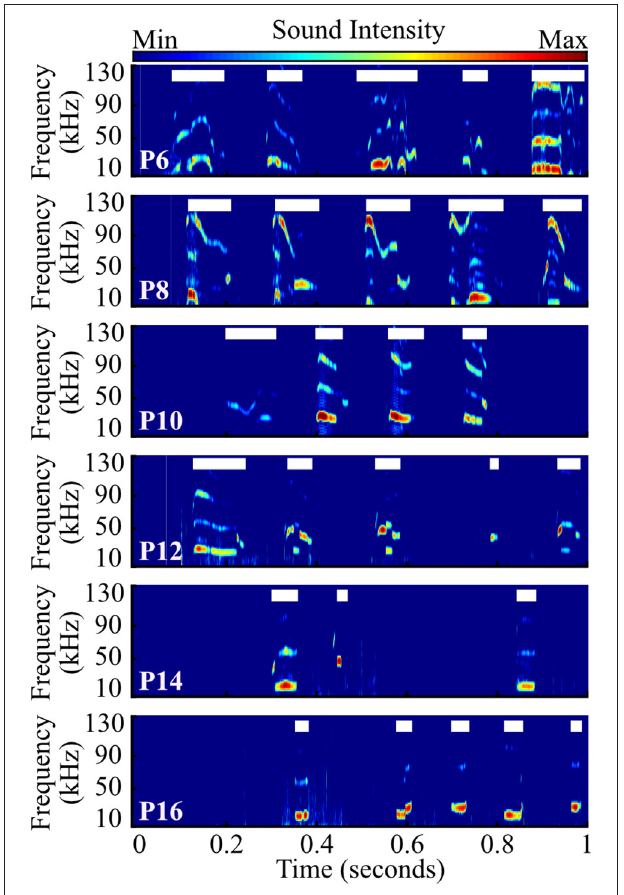
FIGURE 3 | Representative examples of pup vocal activity across development. Example spectrograms contain one second of audio data recorded from prairie vole pups aged P6–P16. Each thick white line shows time when a single vocalization was extracted.